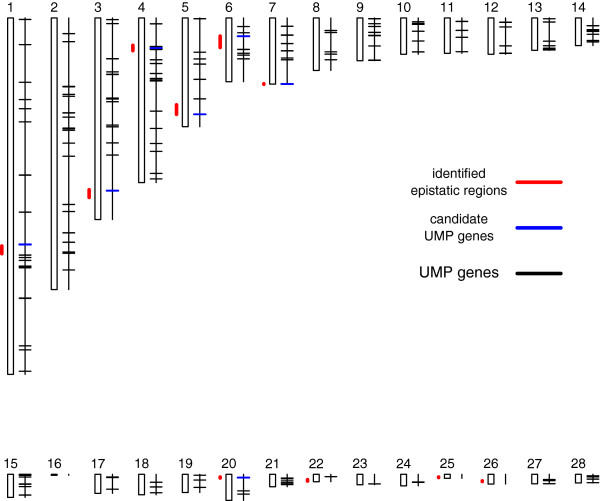
Localisation of epistatic QTL and corresponding candidate genes from the UMP pathway throughout the genome. The 28 vertical boxes represent chicken autosomes GGA1–GGA28. All 10 identified epistatic regions are presented as red vertical bars, and UMP genes within the epistatic regions are presented as blue horizontal lines, while other genes are displayed in black.